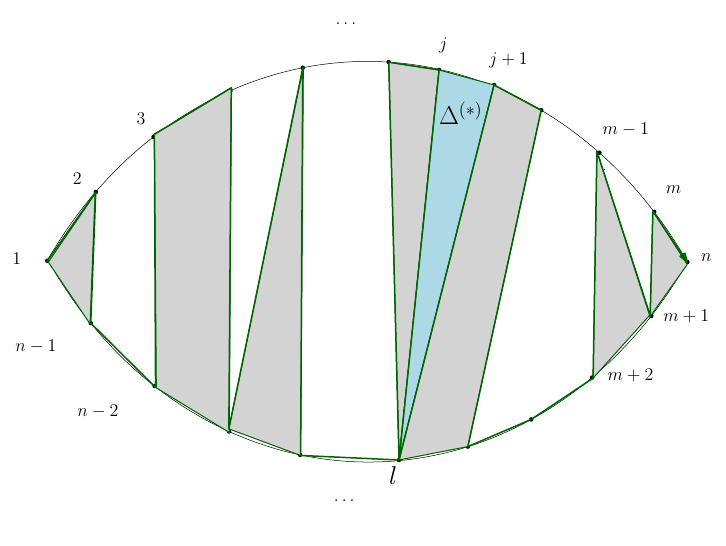
Figure 10 . Singling out (cid:1) ( (cid:3) ) . The path obtained by identifying label j with j + 1 contains m (cid:0) 2 triangles and n (cid:0) 1